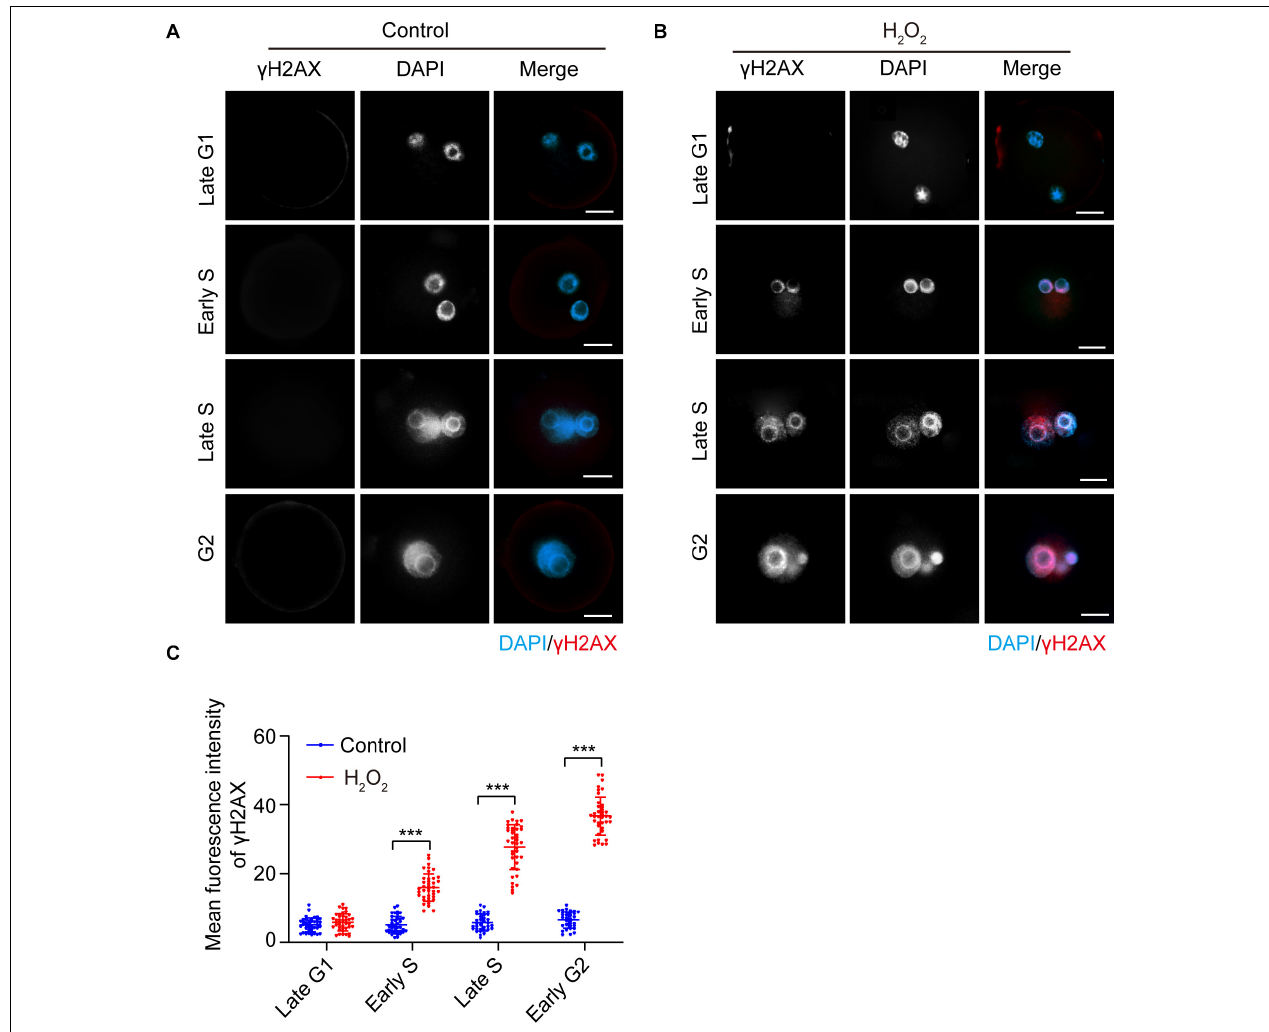
FIGURE 1 | γ H2AX immunostaining (red) detection in the interphase of mouse zygotes. Nuclei were stained with DAPI (blue). (A) Control group. Scale bar = 20 µ m. (B) H 2 O 2 -treated group. Scale bar = 20 µ m. (C) Quantification of the mean fluorescence intensity of γ H2AX in both control and H 2 O 2 -treated zygotes at different stages during interphase. N = 40 zygotes per group at each stage. Results were analyzed by Student’s t -test. *** p < 0.001. Error bars: SD.